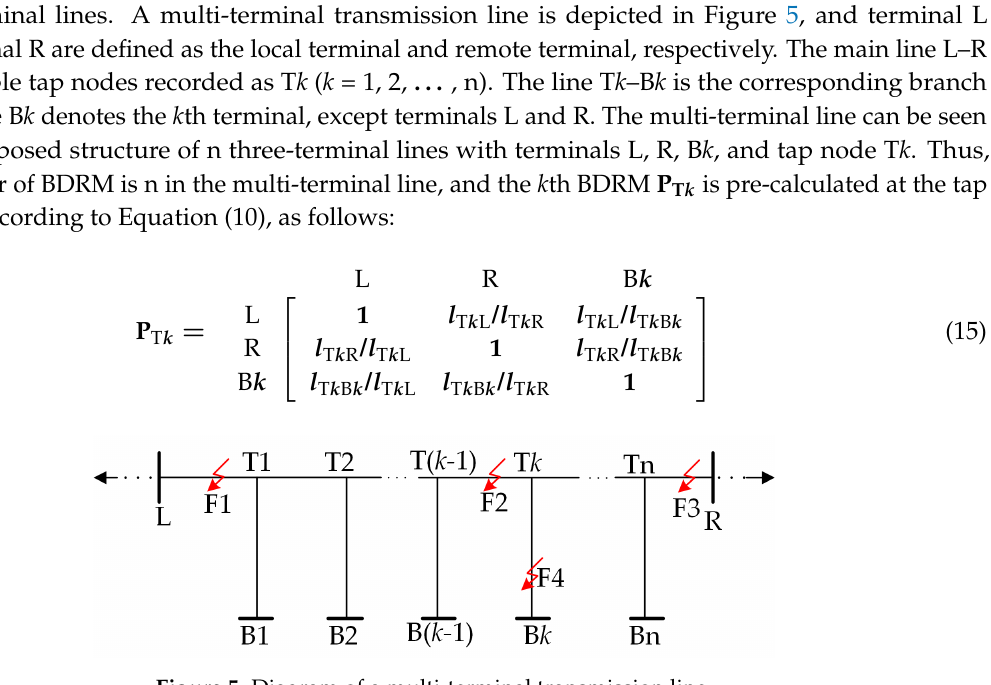
Table 1. Rules to identify fault section.